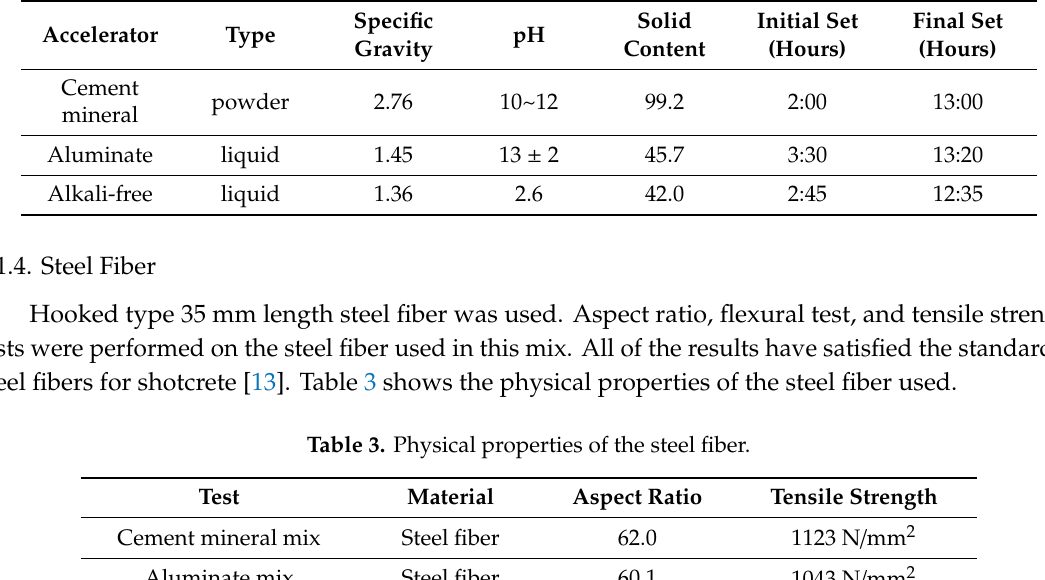
Table 2. Physical properties of the accelerators.